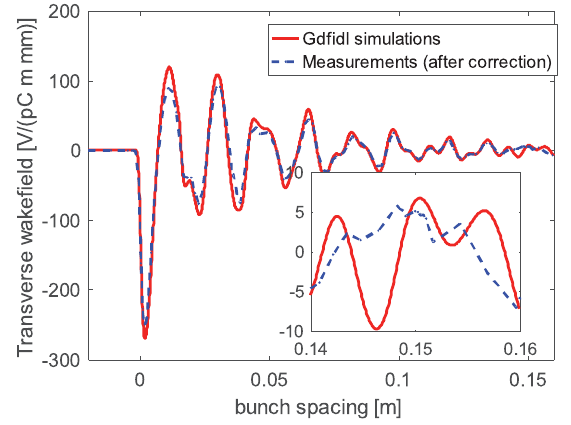
FIG. 2. Results of wakefield measurements.